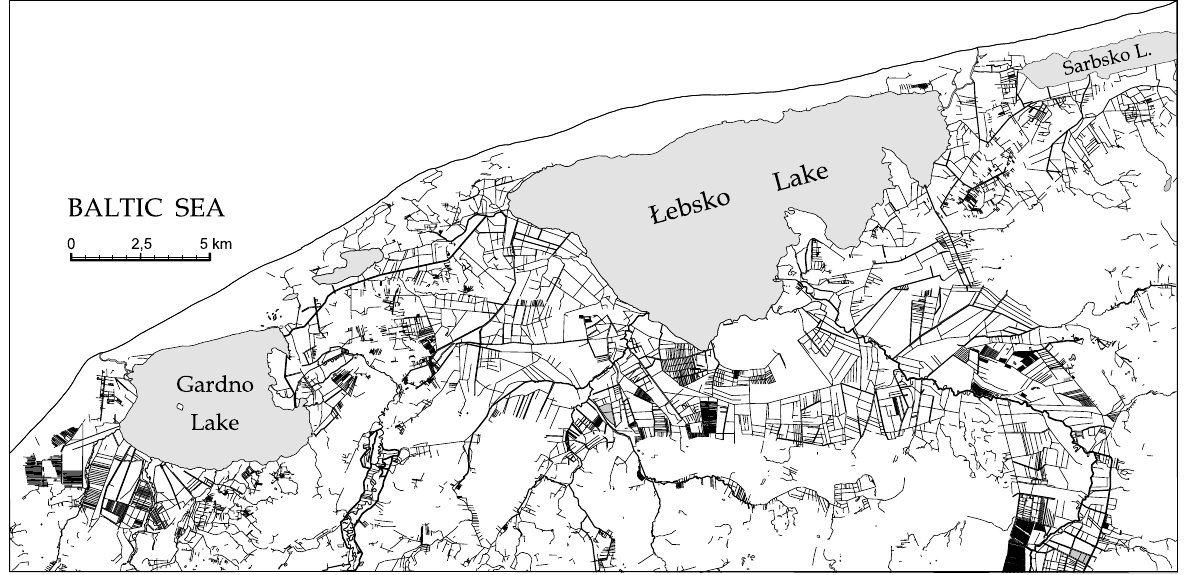
Fig. 4. Hydrographic network in the Gardno-Łeba Lowland in the early 20th c.